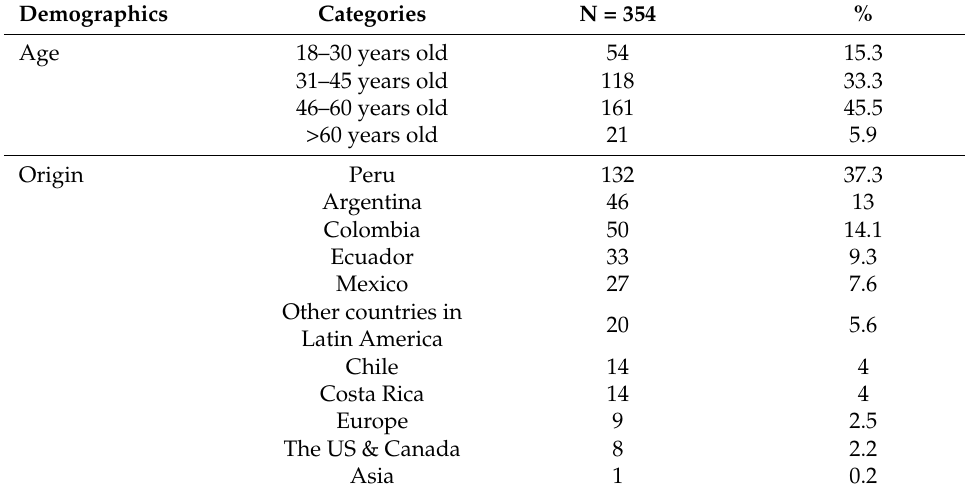
Table 1. Sociodemographic characteristics.